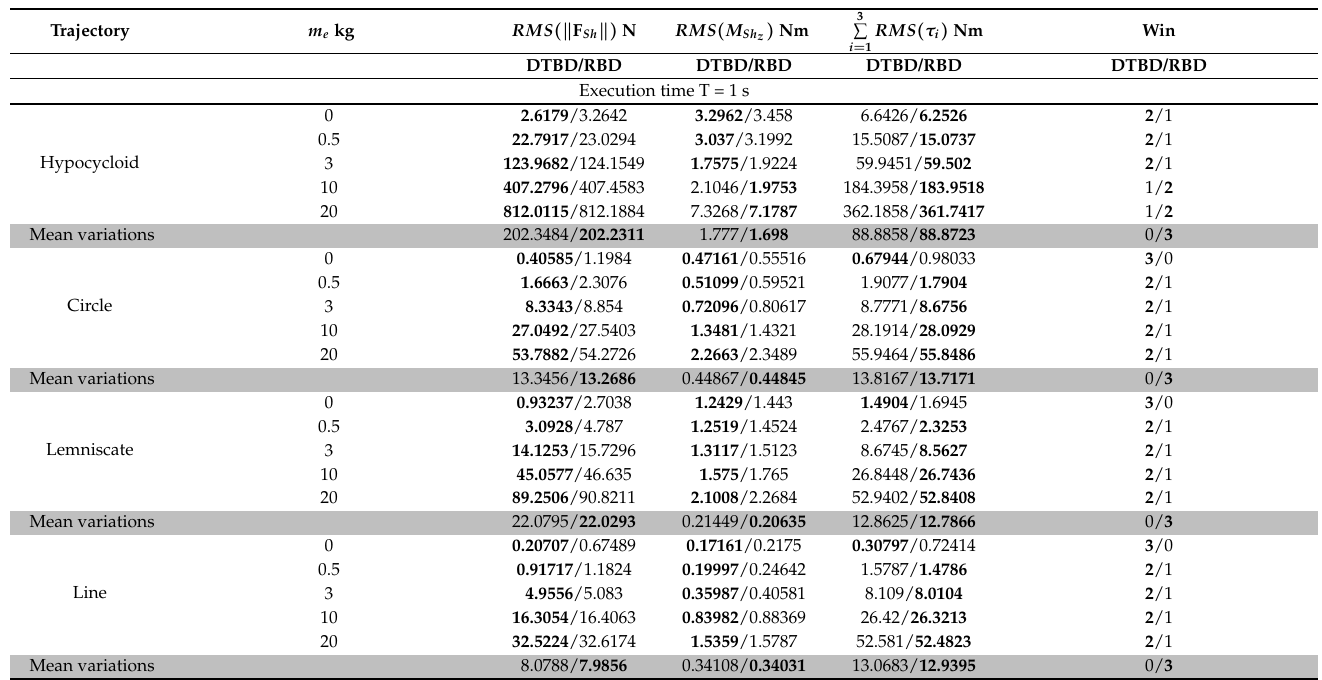
The boldface number indicates the best performance between the design approaches. The shadowed rows “Mean variations” indicate the average of the difference between the RMS value of the indicators with two different masses m e in the end-effector. Table 9. Comparative results of the RBD with respect to the DTBD with different tasks, speeds, and end-effector